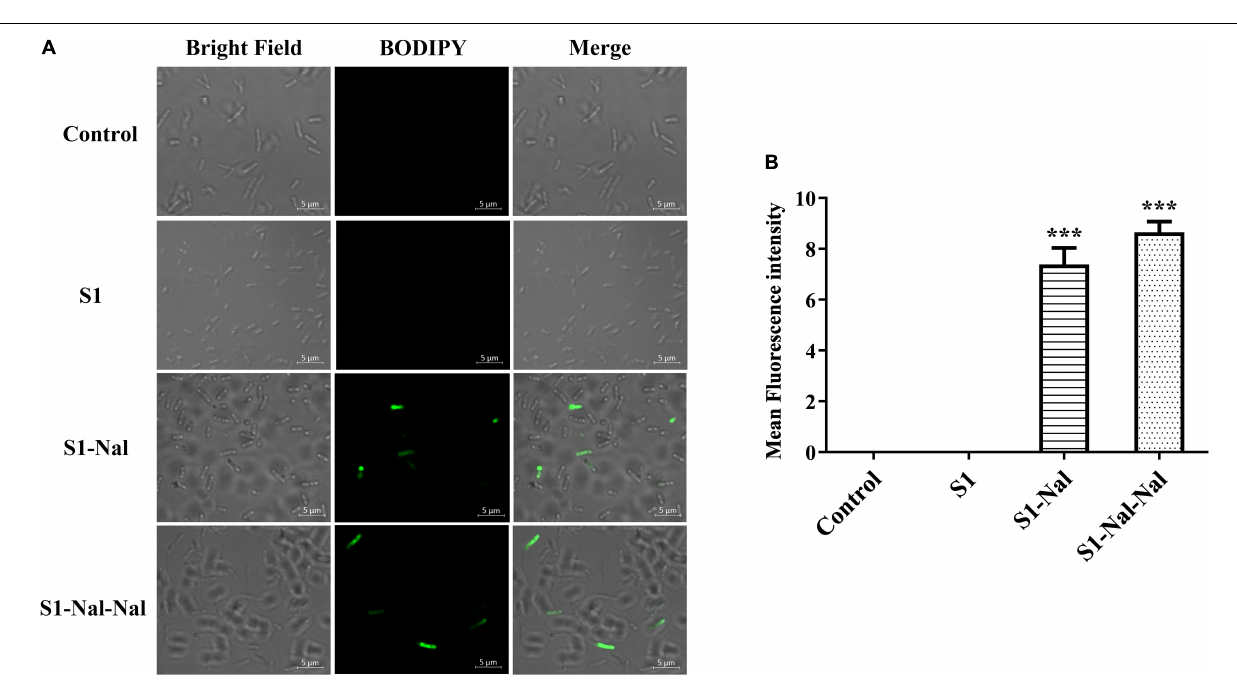
FIGURE 4 | S1-Nal and S1-Nal-Nal increase the uptake of BODIPY-labeled vancomycin in E. coli . (A) Fluorescence images of 10 7 CFU/ml E. coli BCRC 13B0207 treated with 0.5 × MIC of S1, S1-Nal, and S1-Nal-Nal at 37 ◦ C for 30 min, then treated BODIPY-labeled vancomycin for 30 mins (scale bar represents 5 µ m). (B) Mean fluorescence intensity of S1, S1-Nal, and S1-Nal-Nal treated in E. coli BCRC 13B0207. Samples treated with BODIPY-labeled vancomycin only served as a control. Results are presented as means ± SEM, *** P < 0.001 compared with